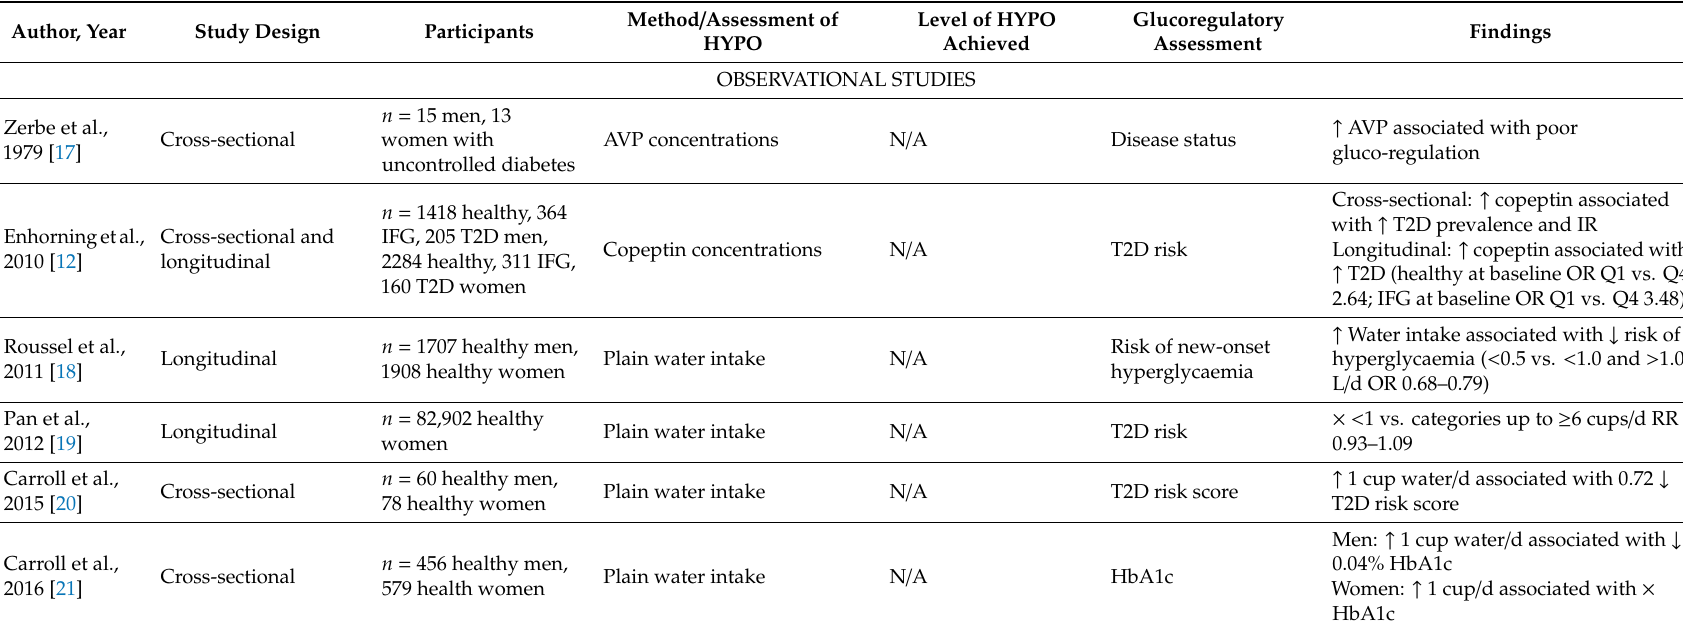
Table 1. Literature pertaining to hydration and